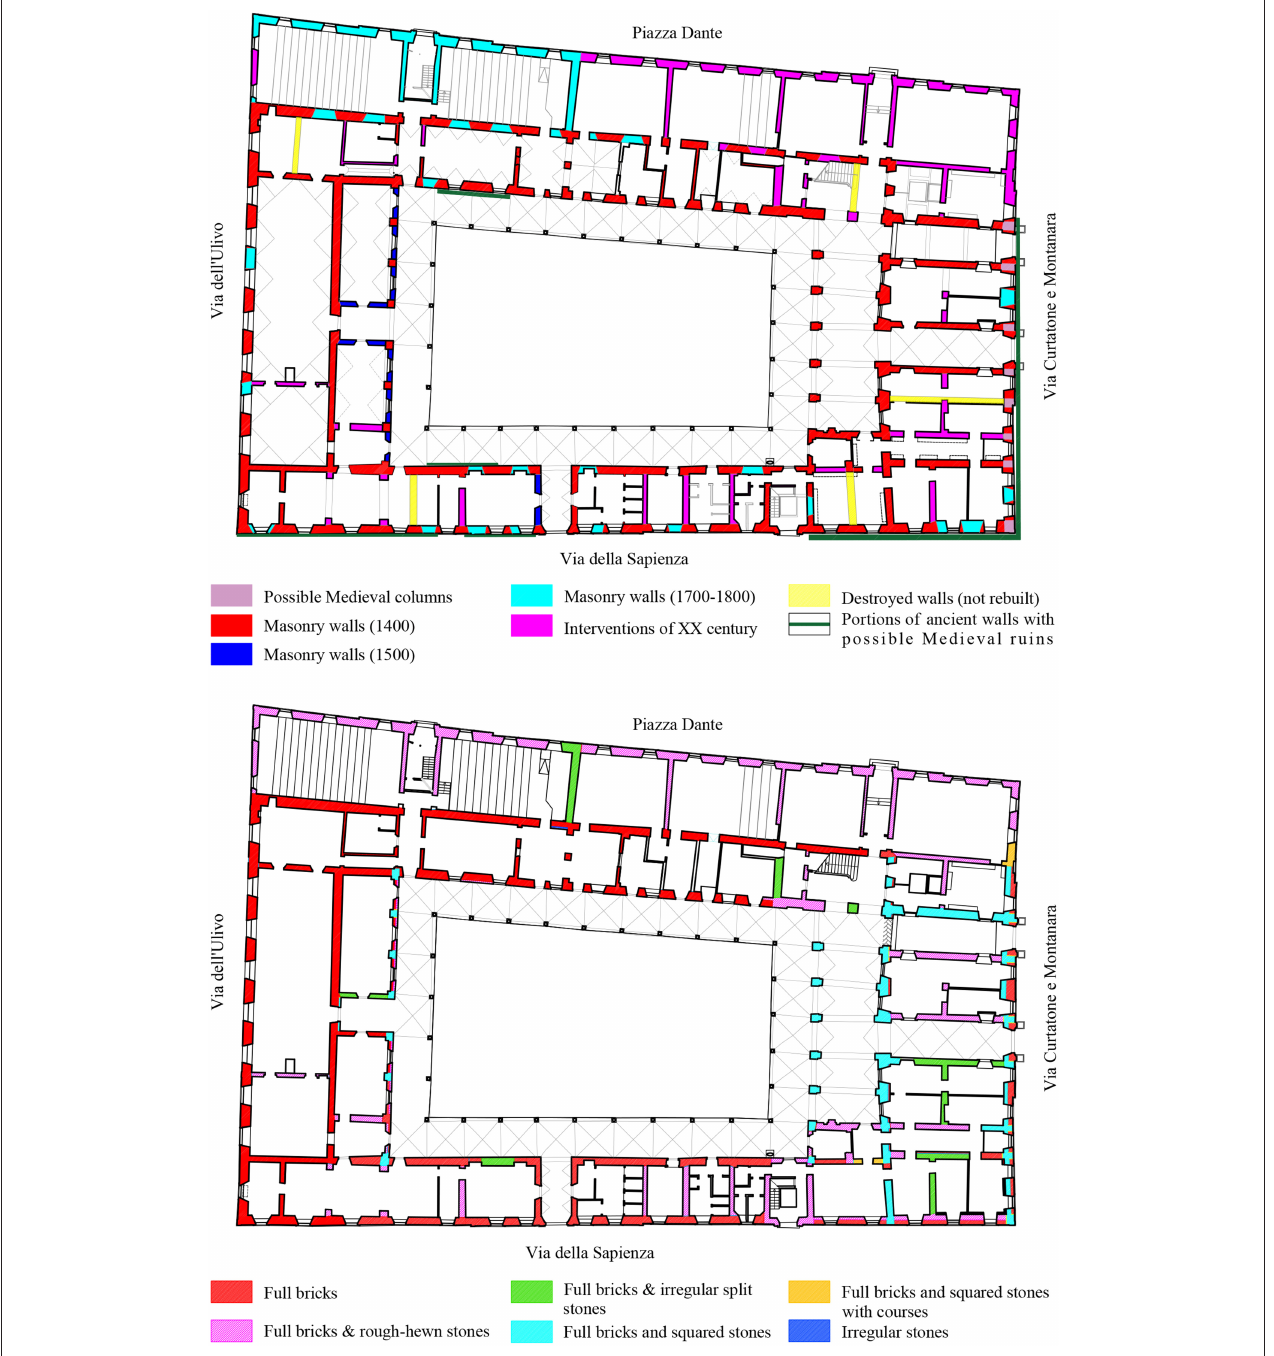
FIGURE 8 | Hypothesis of the evolutive development of the La Sapienza Palace and plan of ground floor with indications of the various types of masonry (Caprili et al.,